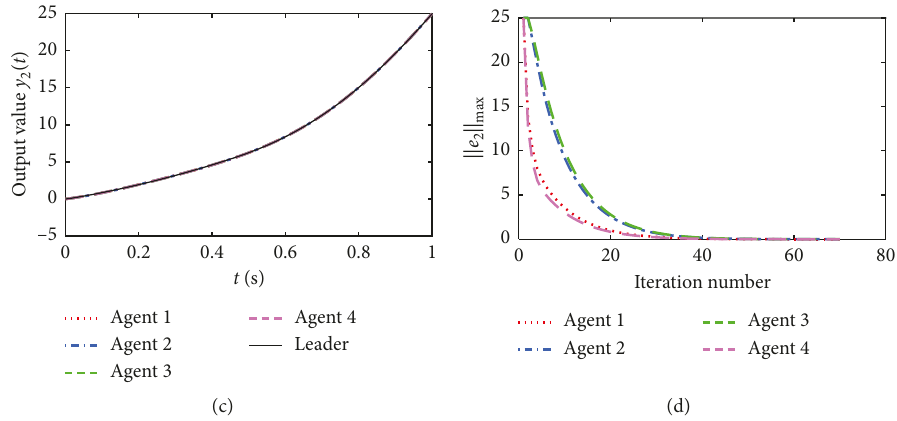
Figure 3: Results of y PD α -type FOILC. (a) Trajectories y 2 with open-loop 2 ( t ) at the 5th iteration. (b) Trajectories y 2 ( t ) at the 20th iteration. (c) Trajectories y 2 ( t ) at the 70th iteration. (d) Tracking error e 2 vs. iteration number.